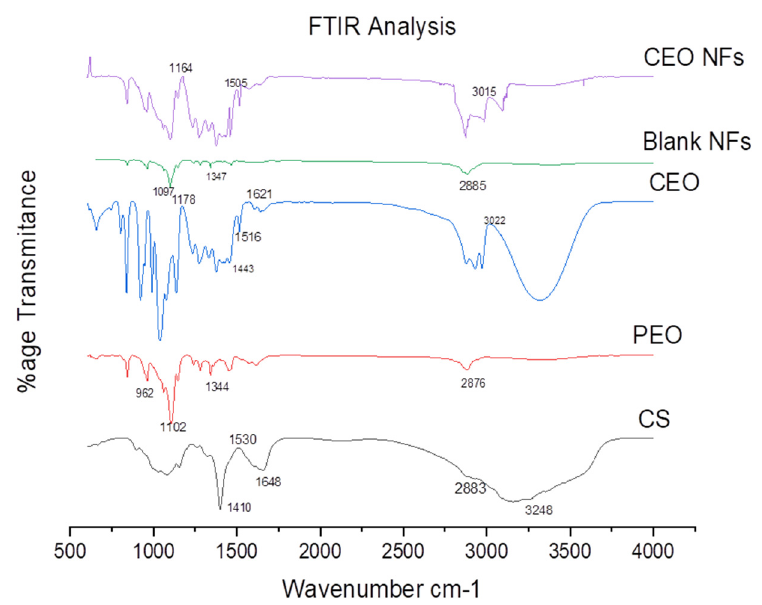
Figure 3. The FTIR spectra of CS, PEO, CEO, Blank NFs, and CEO-encapsulated